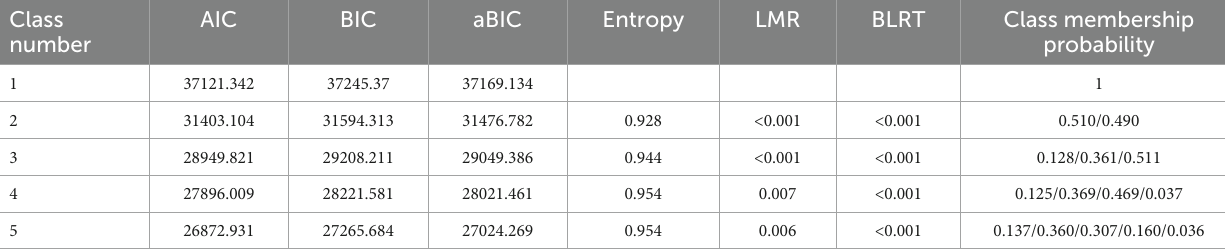
TABLE 3 Model fit indices for latent profile models with different classes.